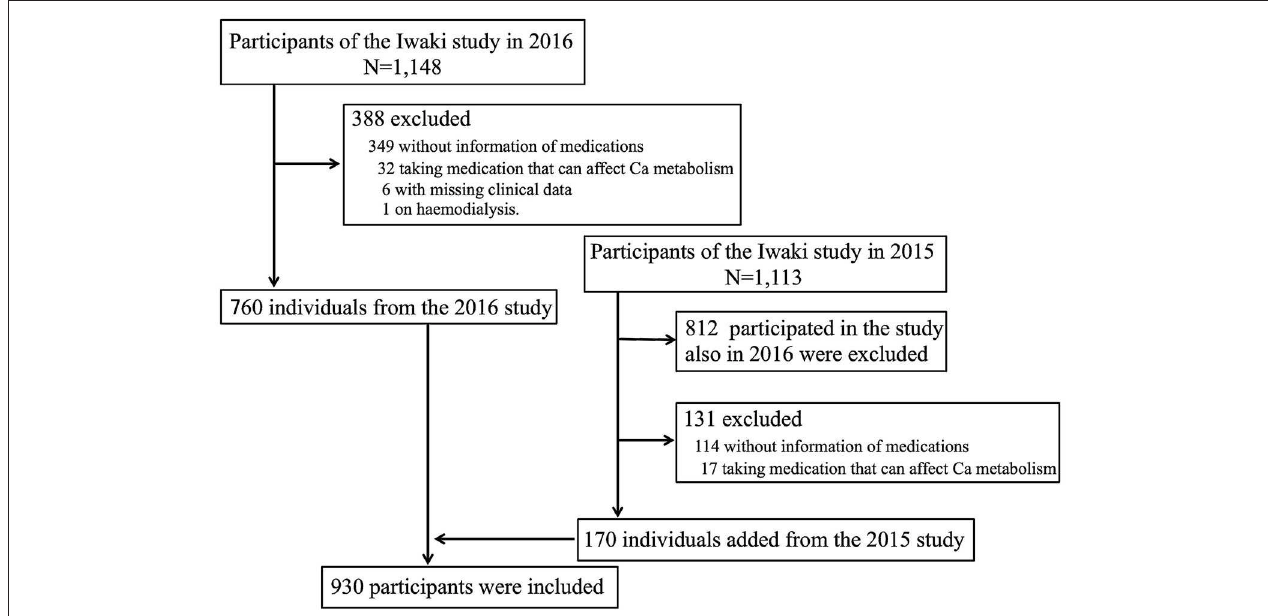
FIGURE 1 | Subject selection flow